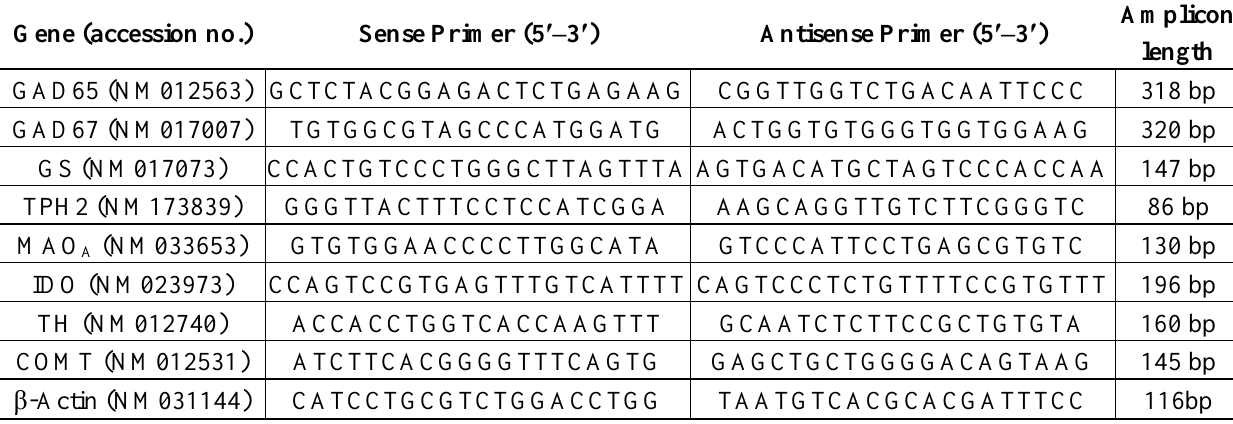
Table 1. Primer sequences used for the qPCR